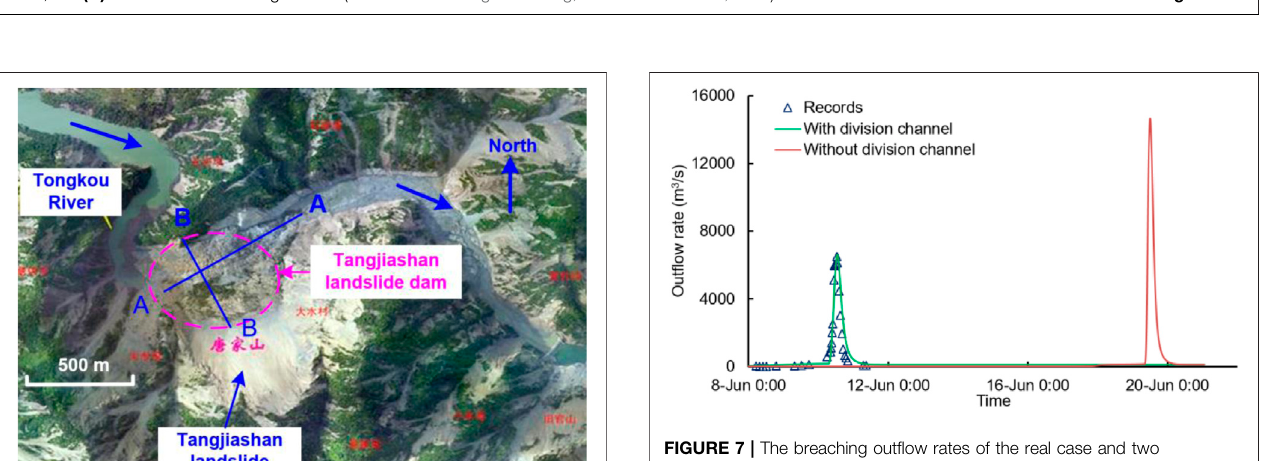
FIGURE5| The locationand cross-section oftheTangjiashanlandslide dam: (A) thelocation ofthedam and theBeichuanTown; (B) the cross-sectionacrossthe river;and (C) thecross-sectionalongtheriver(Modi fi edfromPengandZhang,2012bandShietal.,2015).Notethatthecross-sectionsofA-AandB-Breferto Figure6 .